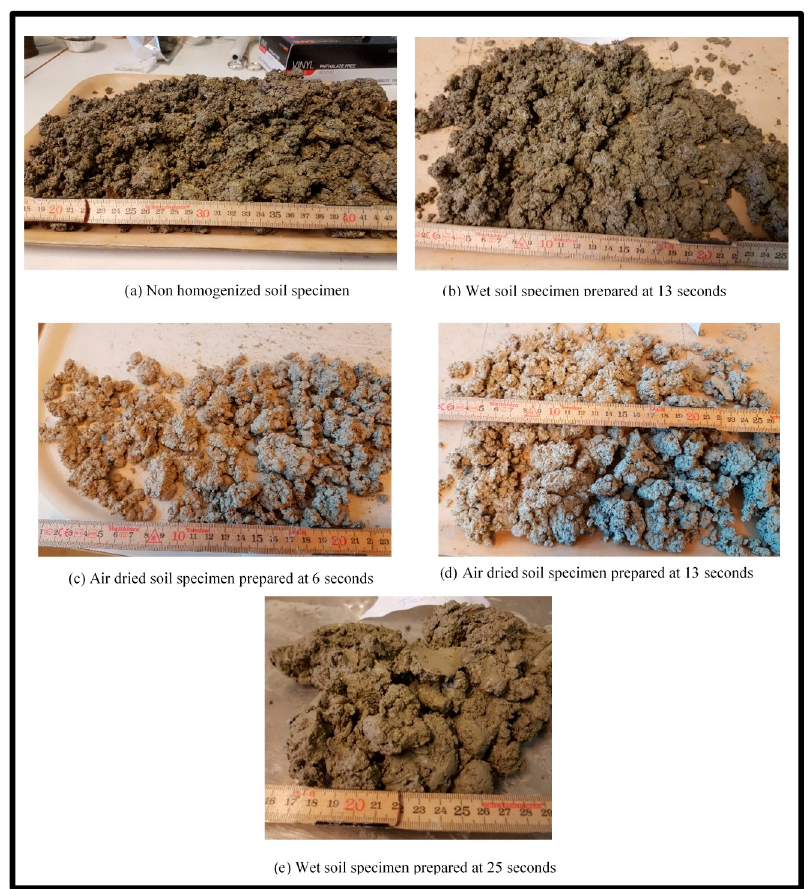
Figure 5. Visual evaluation of Soil 3 before and after disintegration at various times: ( a ) Non homogenized soil specimen; ( b ) Wet soil specimen prepared at 13 seconds; ( c ) Air dried soil specimen prepared at 6 seconds; ( d ) Air dried soil specimen prepared at 13 seconds; ( e ) Wet soil